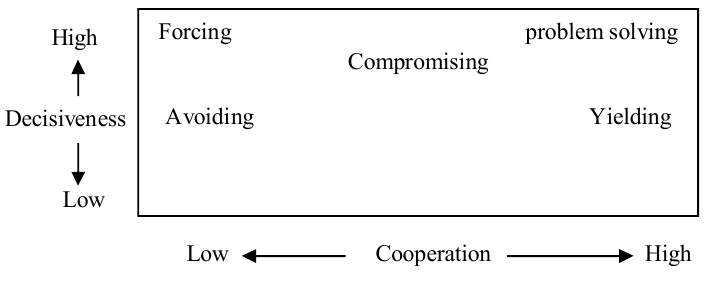
Fig. 1. styles of conflict